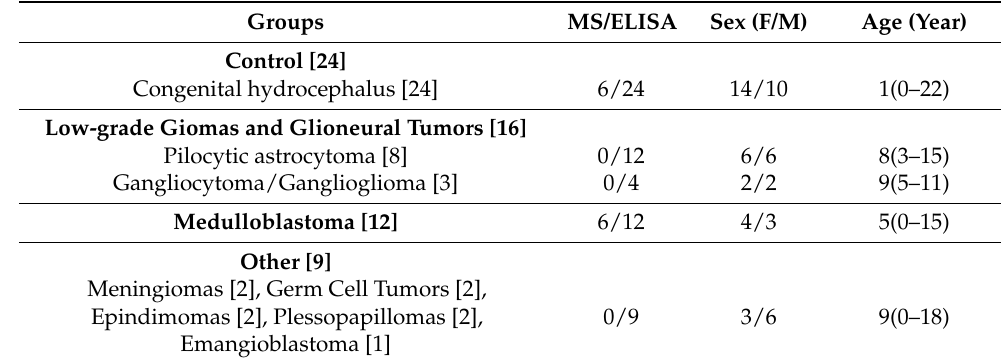
Table 1. Clinical characteristics of the 61 patients in the study. All patients with brain tumors received a histological diagnosis. The abbreviations MS and ELISA indicate that samples were analyzed by MS and/or ELISA, respectively. The total patient number in each clinical group is shown in square brackets. Age is reported as the mean (years) and the range is shown in round